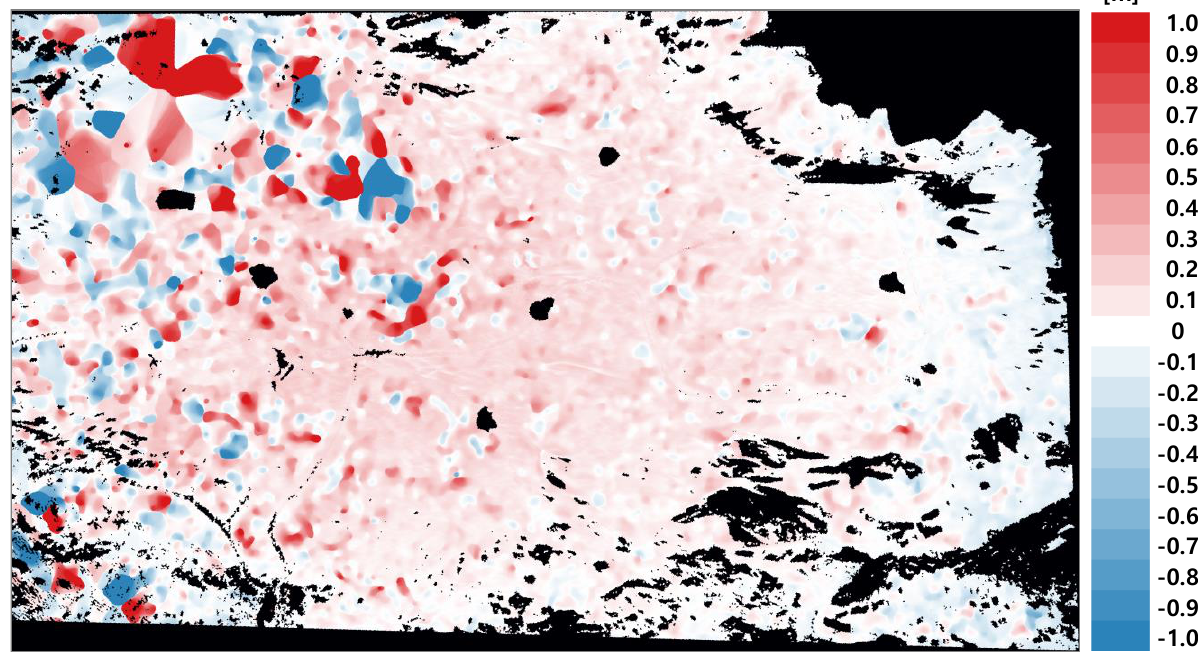
Figure 5. Error map for the DSM derived from UAV